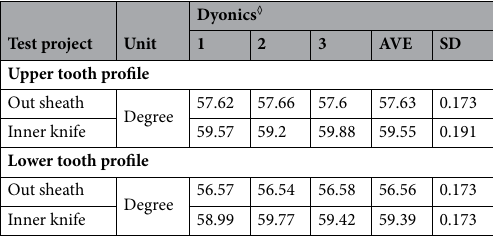
Table 3. Tooth profile and angle of Dyonics ◊ ’s products.